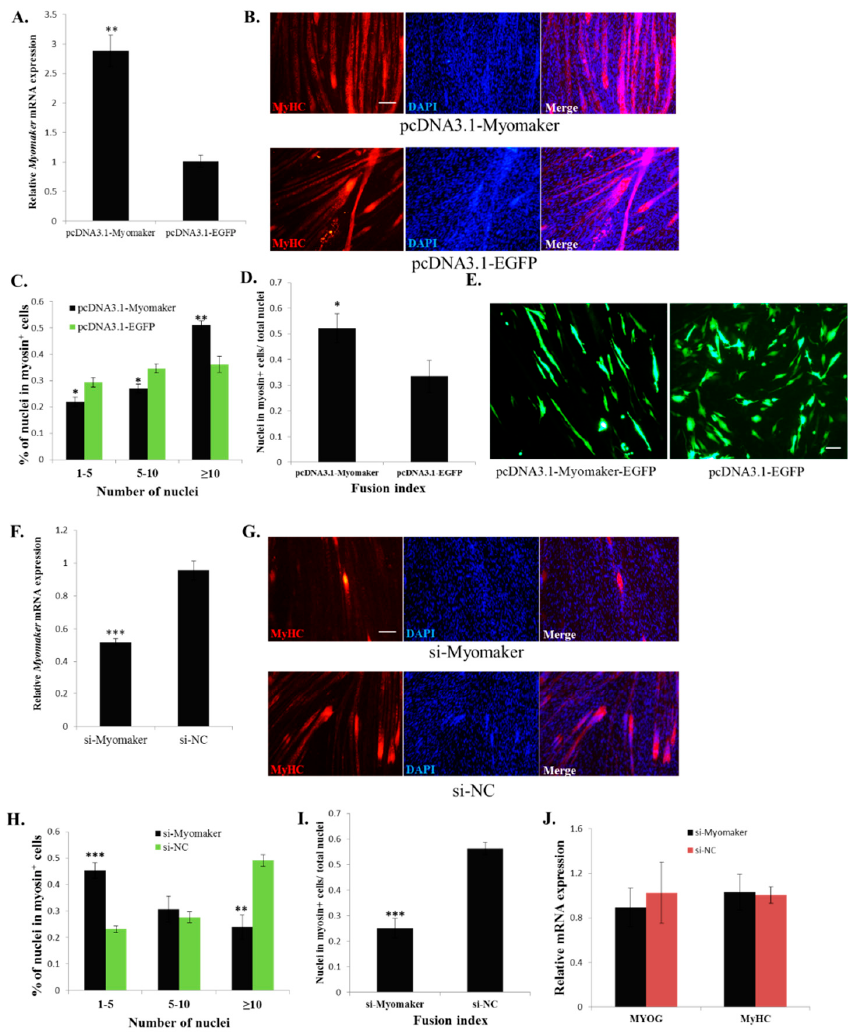
Figure 3. Myomaker is essential for myoblast fusion in chicken. ( A ) Myomaker overexpression via pcDNA3.1-Myomaker transfection significantly increased the Myomaker mRNA level; ( B ) MyHC immunostaining of primary myoblasts transduced with pcDNA3.1-Myomaker or pcDNA3.1-EGFP and differentiated for 48 h. Bar, 100 µm; ( C ) The distribution of myonuclear content in the cells with over-expressed Myomaker or EGFP ( D ) The fusion index of the cells transfected with pcDNA3.1-Myomaker or pcDNA3.1-EGFP; ( E ) Fluorescence images of myoblasts transfected with pcDNA3.1-Myomaker-EGFP or pcDNA3.1-EGFP at 36 h. Bar, 50 µm; ( F ) Myomaker knockdown via